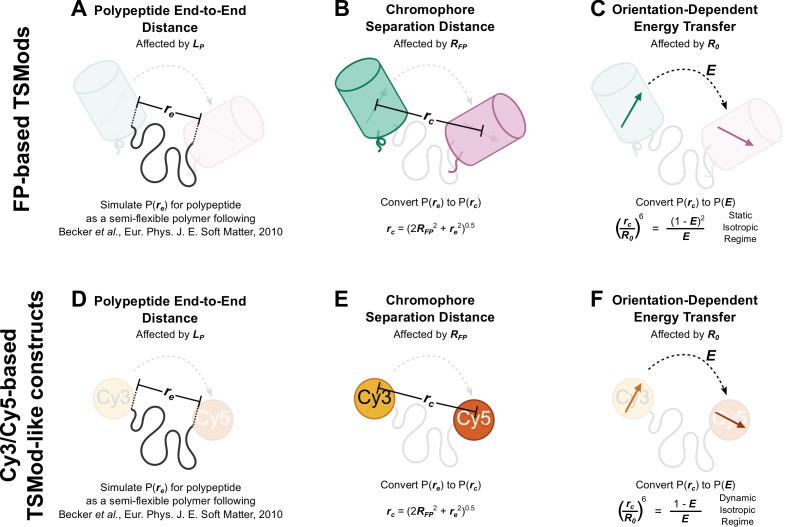
Schematic depiction of biophysical model describing the mechanical sensitivity of TSMods.(A-C) Mechanical sensitivity of FRET-based TSMods depends on the mechanical properties and length of the extensible domain (A), the physical separation of the chromophores within the FPs (B), and the relative orientation and timescale of rotation of the FPs (C). (D-F) Similarly, the mechanical sensitivity of FRET-based TSMod-like constructs which utilize Cy3 and Cy5 as the fluorescent moiety depends on the mechanical properties and the length of the extensible domain (D), the physical separation of the organic dyes (E), and the relative orientation and timescale of rotation of the dyes (F). Note when modeling large FP-based TSMods, the static isotropic regime of energy transfer is valid, while FRET between organic dyes is more appropriately described by the dynamic isotropic assumption of the classical Förster equation (Vogel et al., 2014).